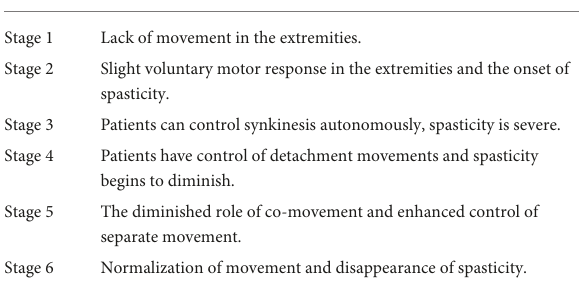
TABLE 1 Description of each Brunnstrom recovery stage (Naghdi et al.,